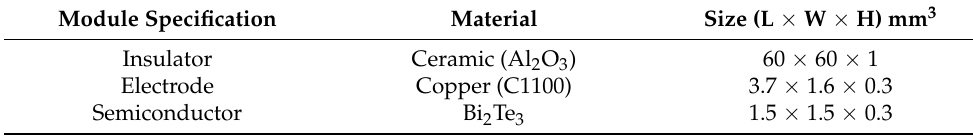
erators (TEG Figure 3. Arrangements of thermoelectric generators. Figure 3. Arrangements of thermoelectric generators. Table 1. Specification of semiconductor. Table 1. Specification of semiconductor.